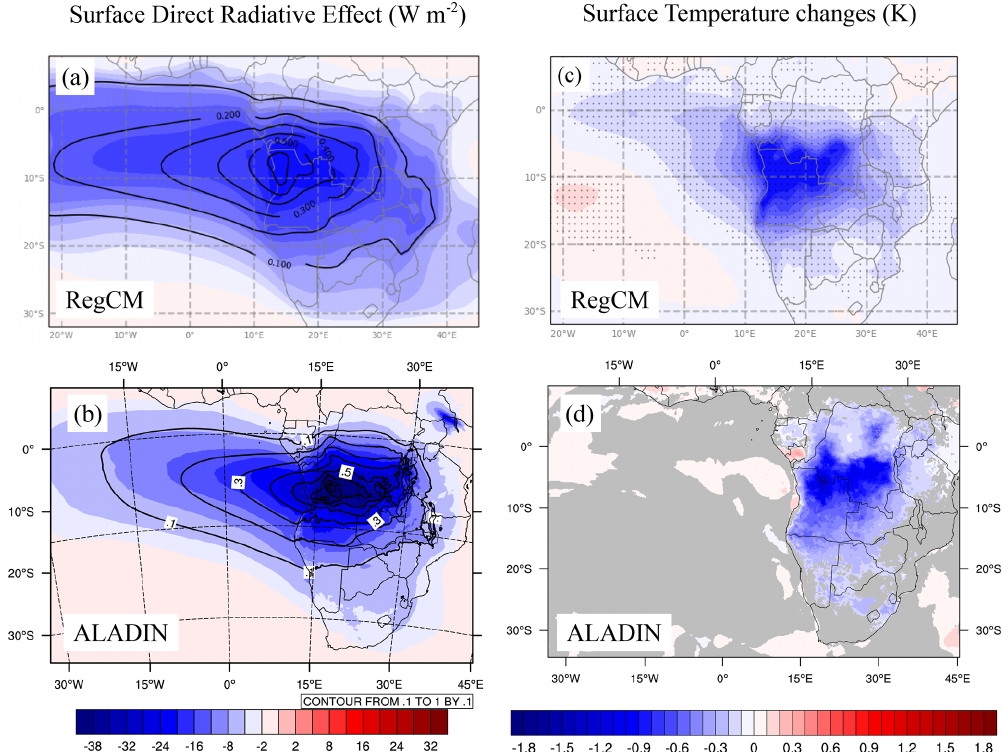
Figure 7. Seasonal-mean (JAS) DRE (Wm − 2 ) exerted by BBAs at the surface in the shortwave (all-sky conditions) for the ALADIN (b) and RegCM (a) models. The AOD values of BBAs are indicated by the black lines. Seasonal-mean (JAS) changes in the surface temperature due to the BBA DRE for the ALADIN (d) and RegCM (c) . For the surface temperature map, the grey (not dashed) areas are not statistically significant at the 0.05 level for ALADIN